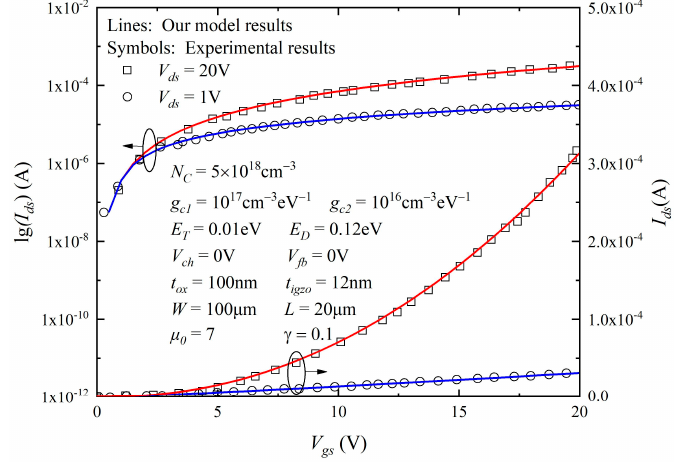
Figure 10. Comparisons of transfer characteristics between our model results (curves) and experi- mental data [36].